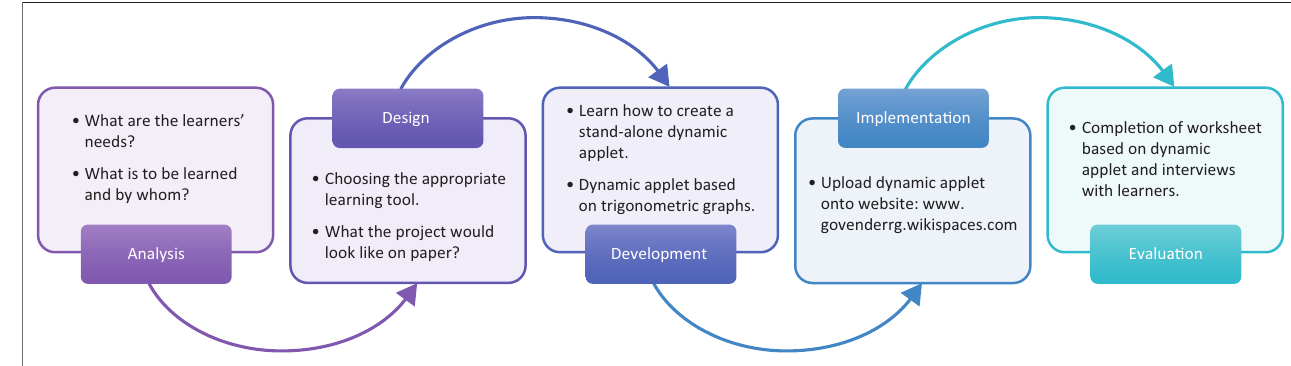
FIGURE 2: The ADDIE model as used in this case